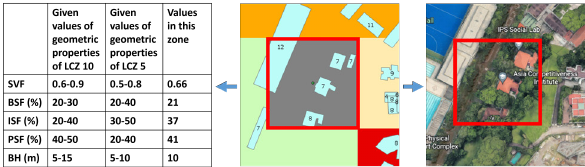
Figure 4. An example of the misclassification from LCZ 5 into LCZ 10 with the direct matching method (comparison between vector GIS data and satellite imagery in Google